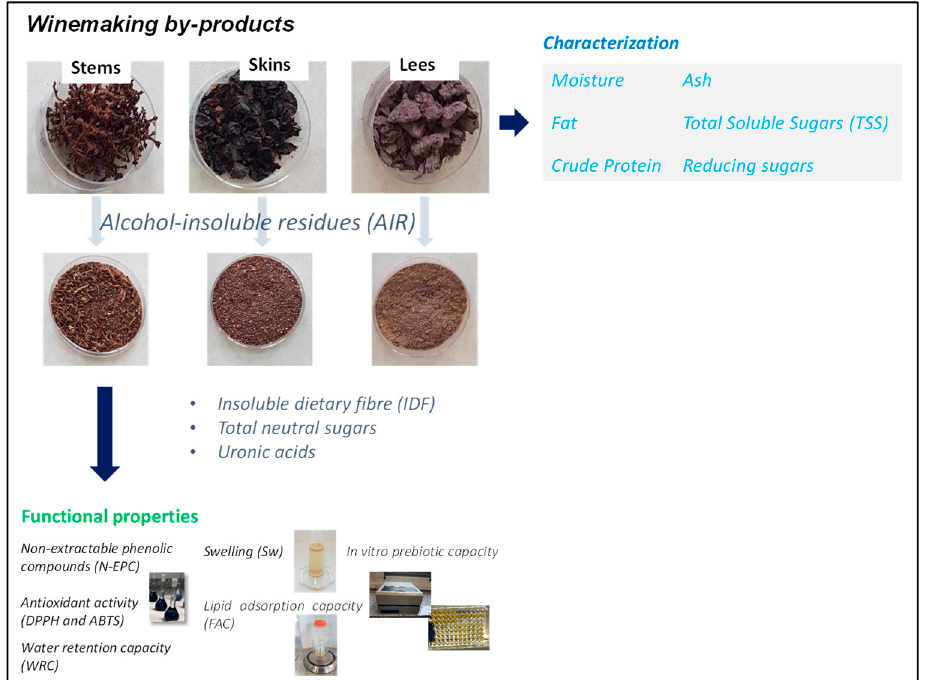
Figure 1. Graphic diagram of the study design.